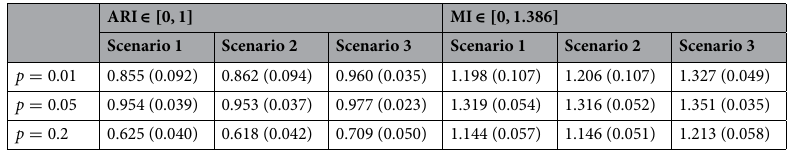
ˆ δδδ with standard deviations in